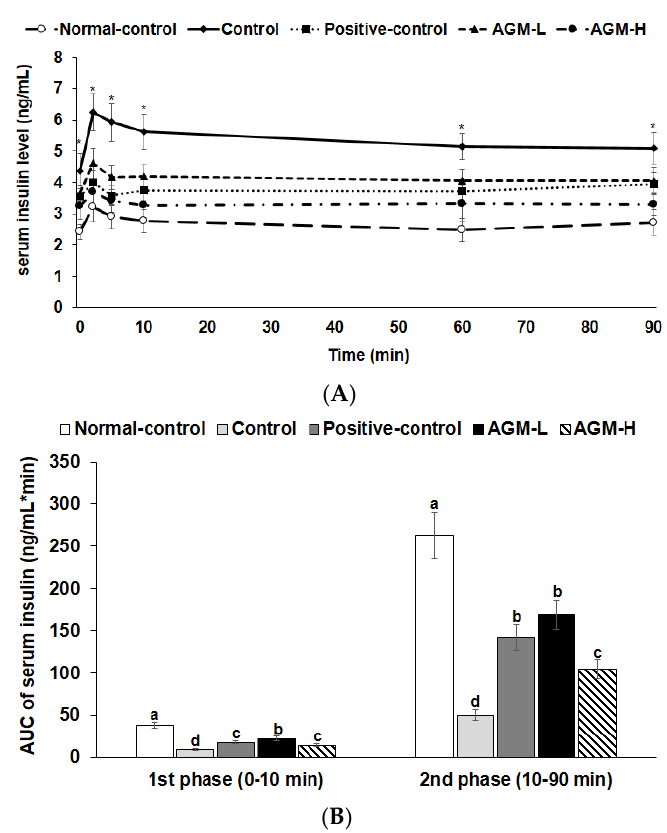
free-dried aronia, red ginseng, mushroom and nattokinase. Px rats fed a high fat diet supplemented with (1) 0.5 g mixture/kg bw/day (AGM-L), (2) 1 g mixture/kg bw/day (AGM-H), (3) 1 g dextrin /kg bw/day (control), or (4) metformin (120 mg/kg body weight; positive-control) for 12 weeks. Sham- operated rats (normal-control) fed the same diet of the control. a,b,c,d Values on the same row with different superscripts were significantly different at p < 0.05.